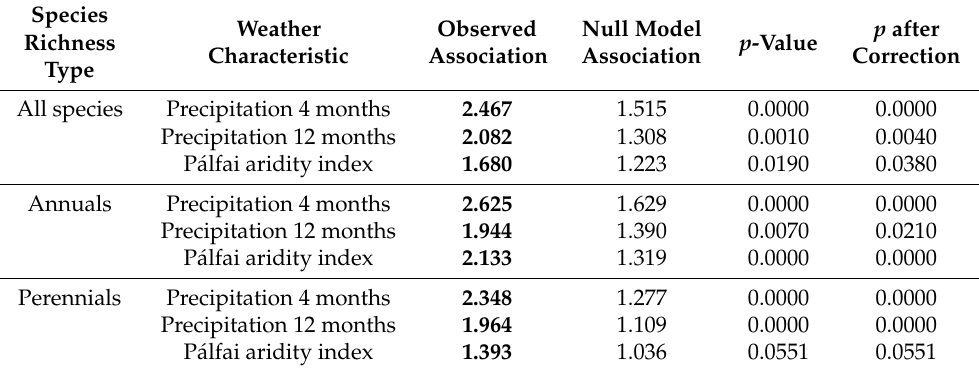
Table 4. Temporal associations between drought events and the local minima of species richness. Corrected p -values were adjusted for multiple tests by the Bonferroni–Holm method. Bold numbers indicate significant